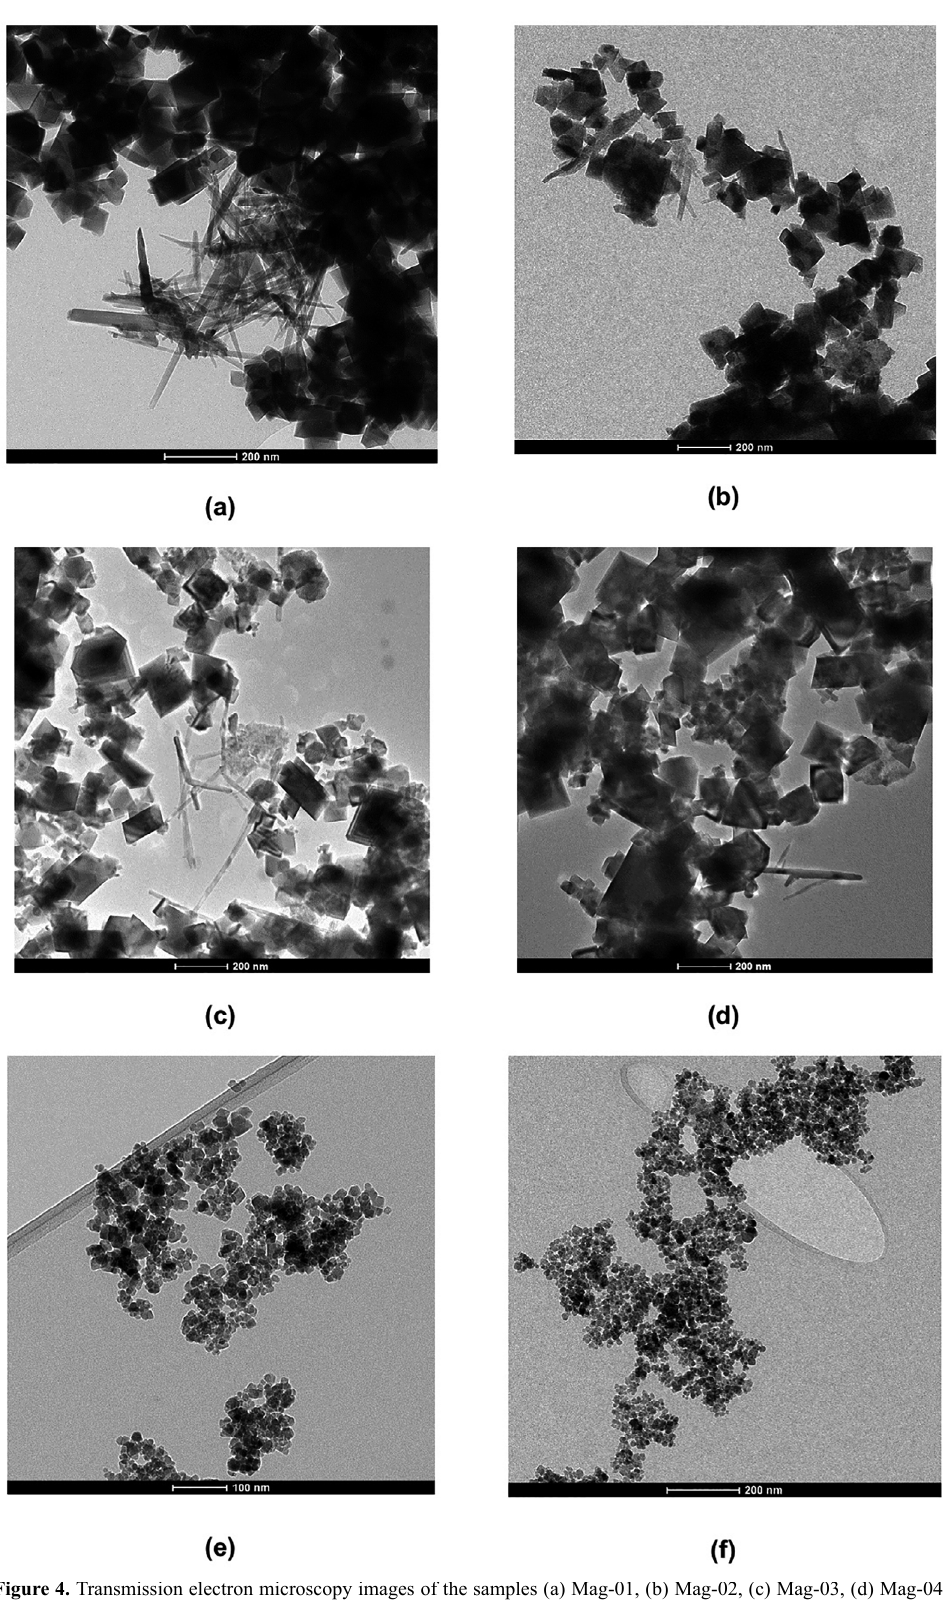
Figure 4. Transmission electron microscopy images of the samples (a) Mag-01, (b) Mag-02, (c) Mag-03, (d) Mag-04, (e) Mag-05 and (f)